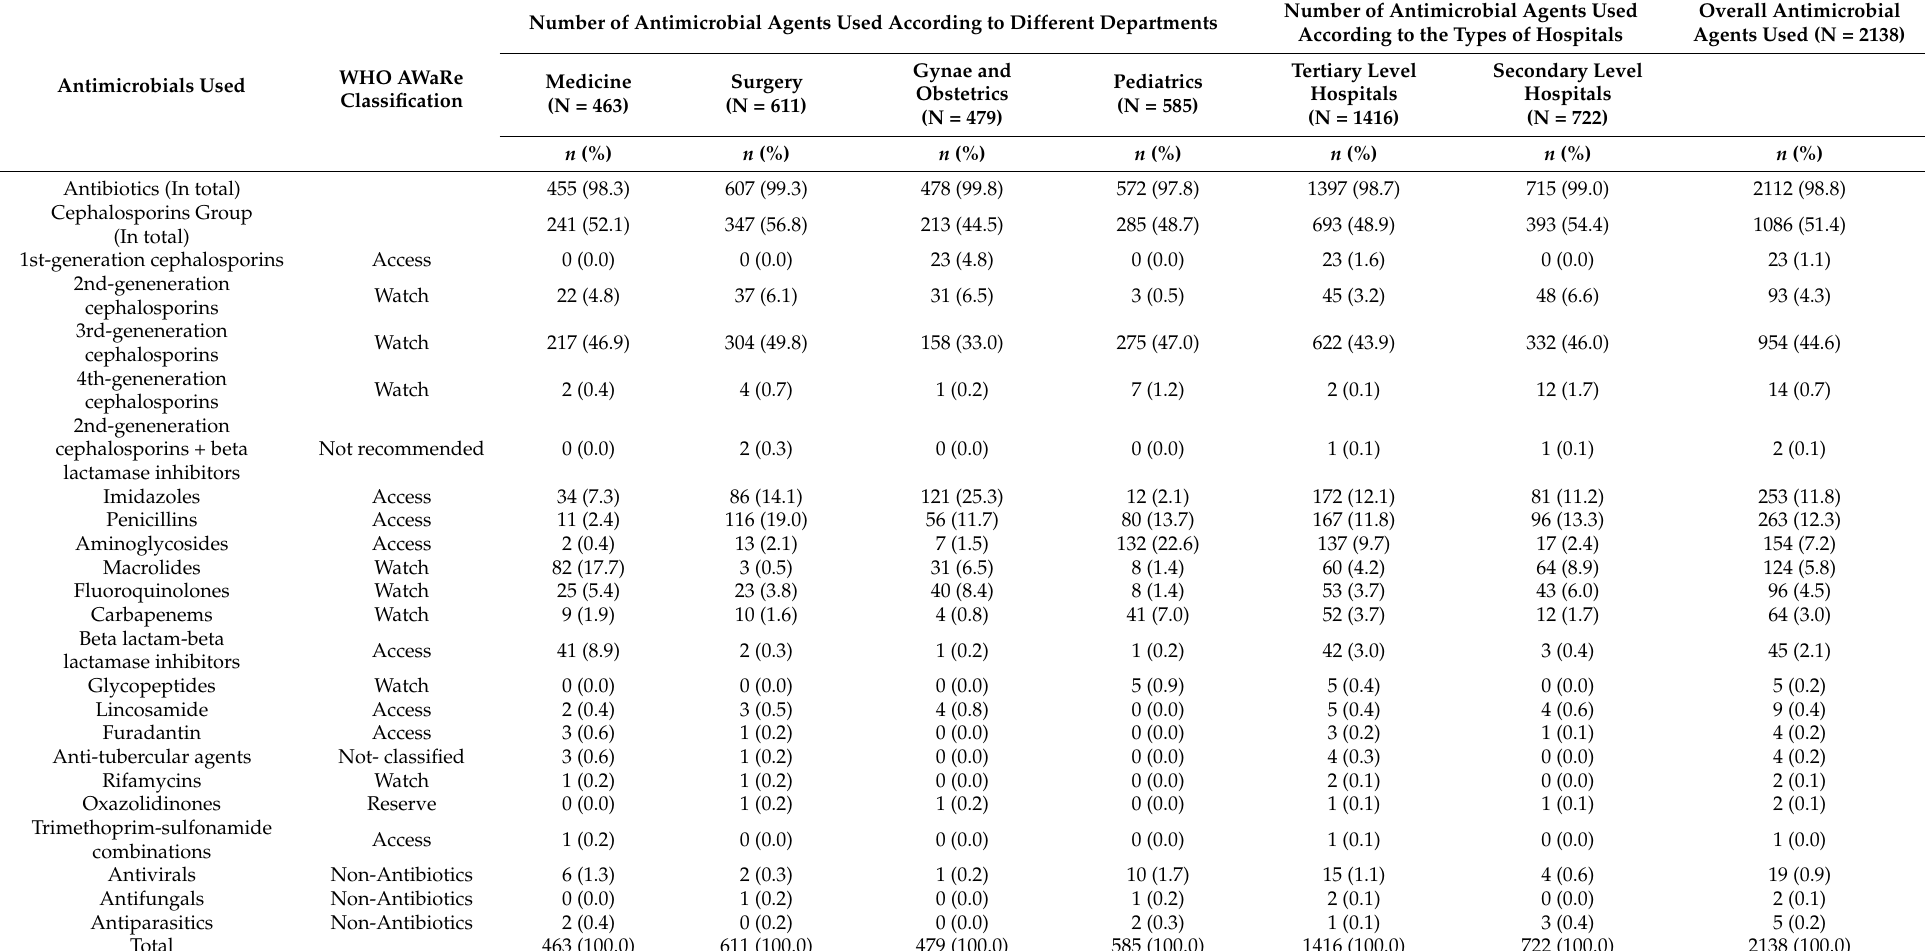
Table 3. Distribution of antimicrobial use according to different departments and types of hospitals in Bangladesh from February to April 2021.